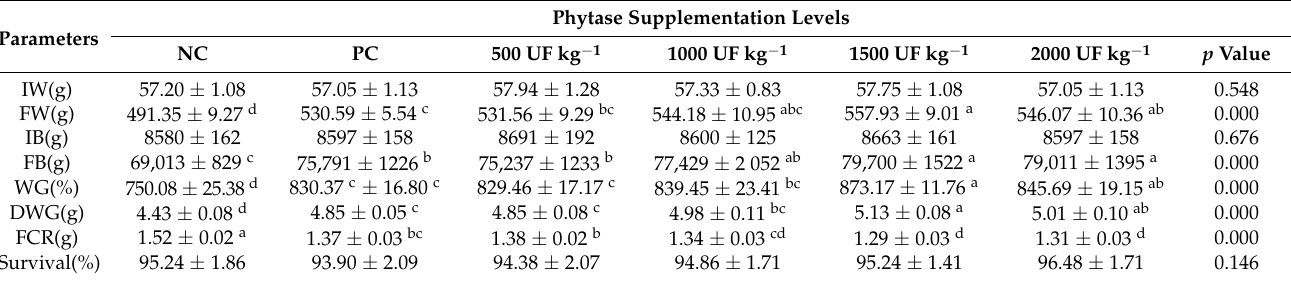
Table 3. Growth performance of Nile tilapia fed diets supplemented graded levels of